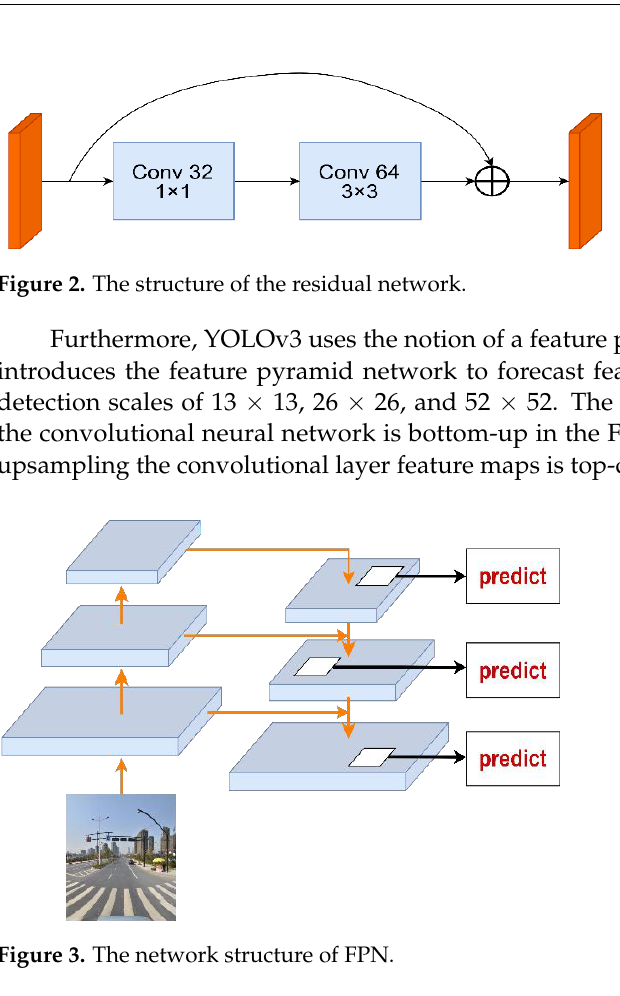
Figure 3. The network structure of FPN.